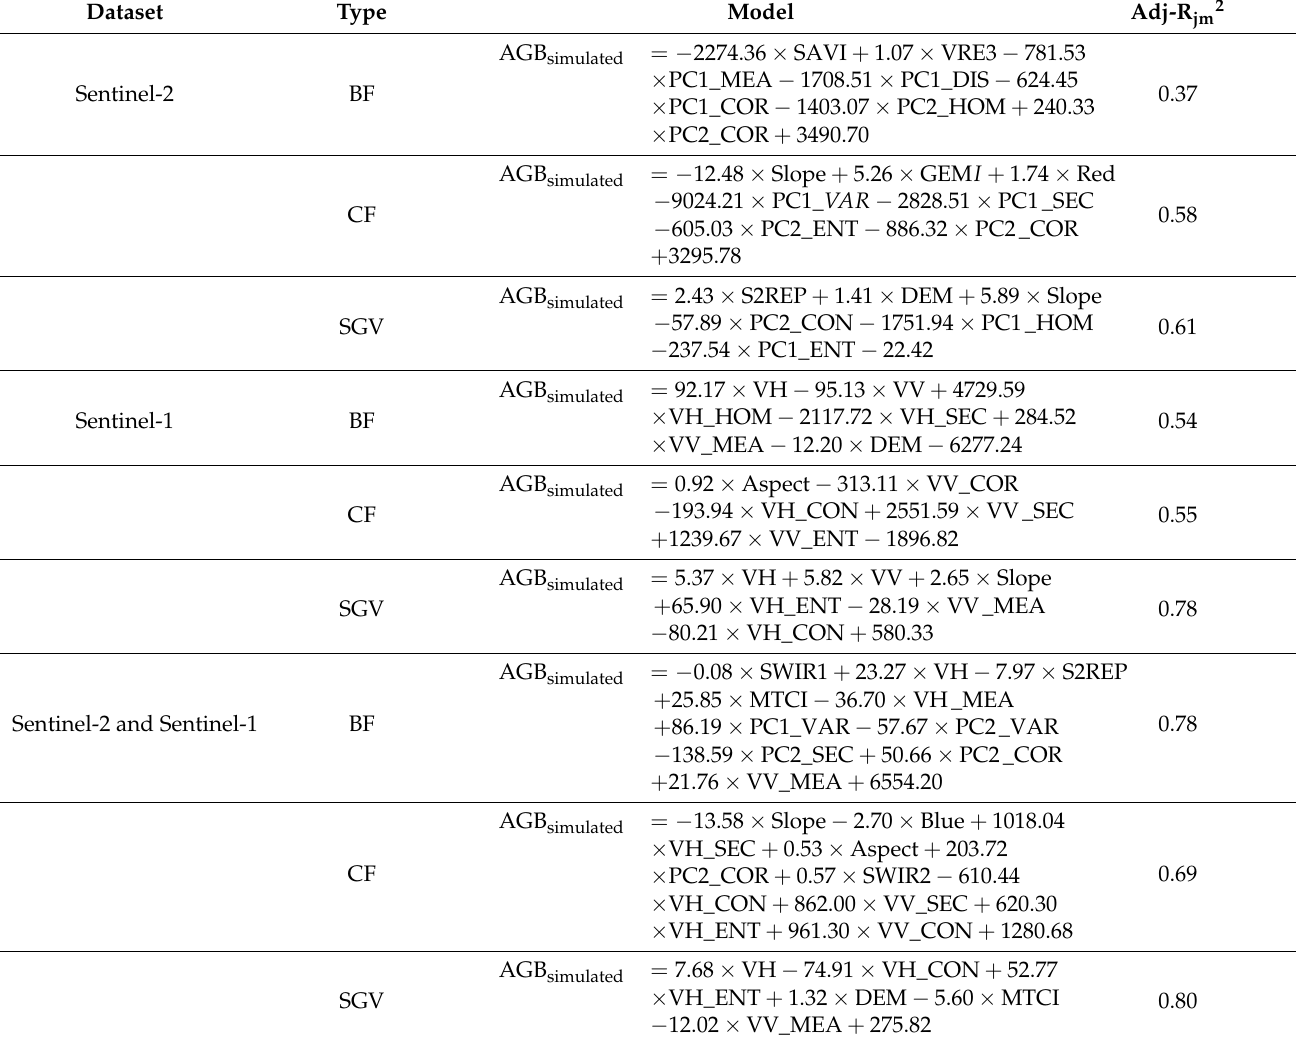
Table 5. Stepwise regression models for AGB of different types of